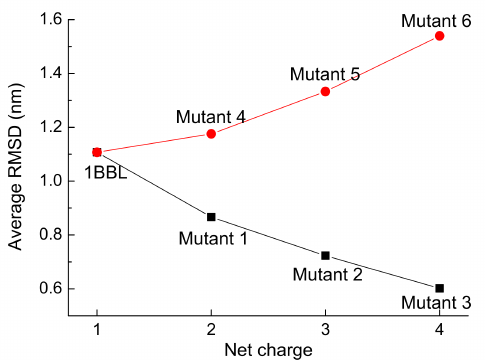
Figure 9. (Color online) The average value of RMSD versus the net charge of the protein